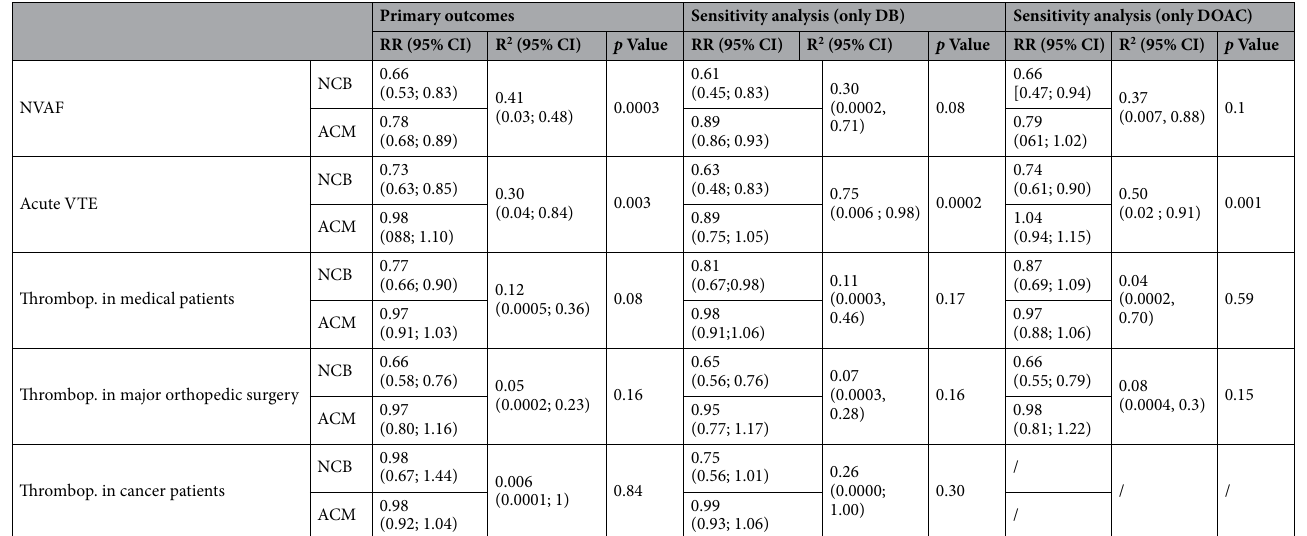
Table 2. Primary and sensitivity analysis for all the studied diseases. ACM all-cause mortality, CI confidence interval, DB double-blind, DOAC direct oral anticoagulants, NCB net clinical benefit, NVAF non-valvular atrial fibrillation, Thrombop . thromboprophylaxis, RR relative risk, R 2 coefficient of determination, VTE venous